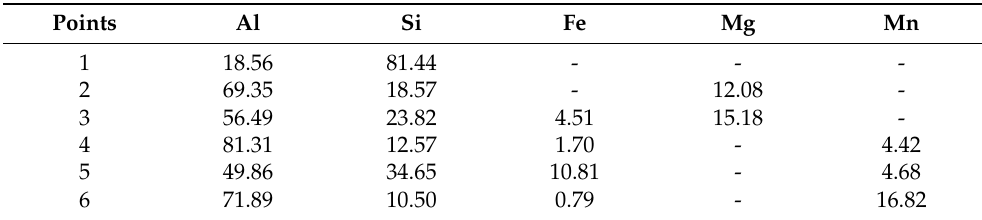
Table 2. EDS results of the points in Figure 4 (Atomic